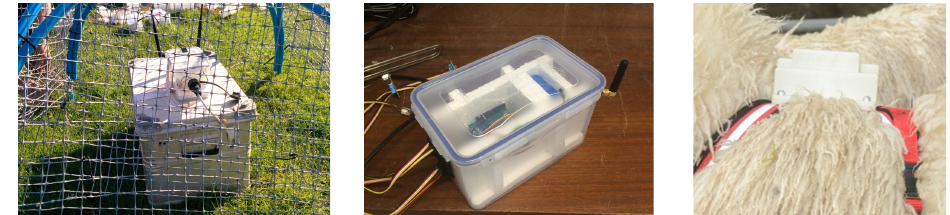
Figure 4. IoT nodes (from left to right: relay, soil node, and livestock node on a